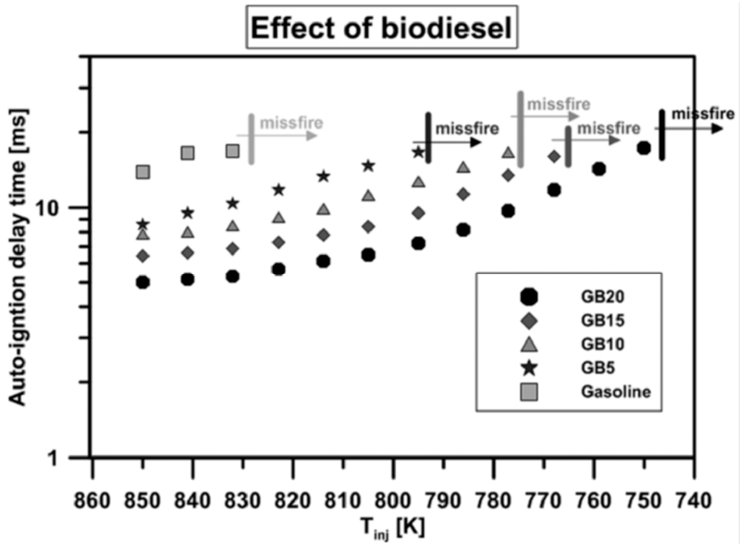
Figure 9. Effect of the biodiesel fraction on auto-ignition [Reproduced with permission from Vu, D.N.; Das, S.K.; Jwa, K.; Lim, O., Proc. Inst. Mech. Eng. Part D J. Authomob. Eng.; published by SAGE publication, 2018.].